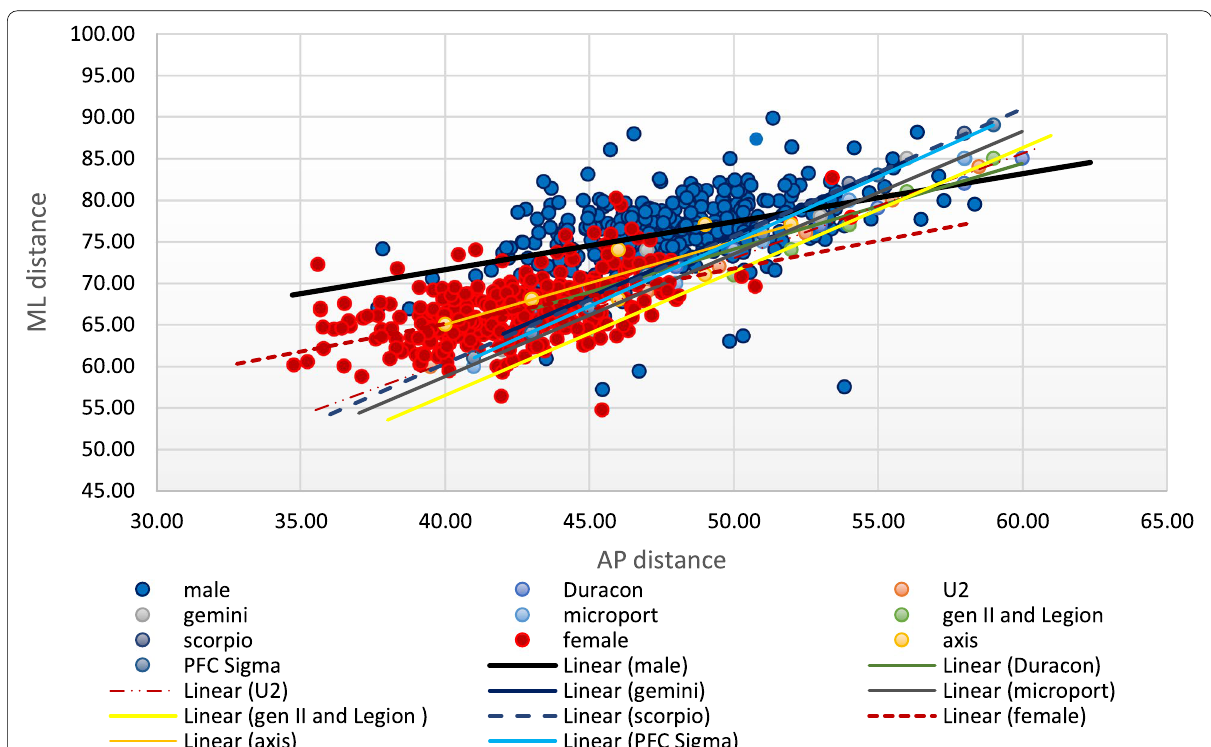
Fig. 5 The AP and ML dimensions of the Filipino proximal tibia and their correlation with TKR tibial